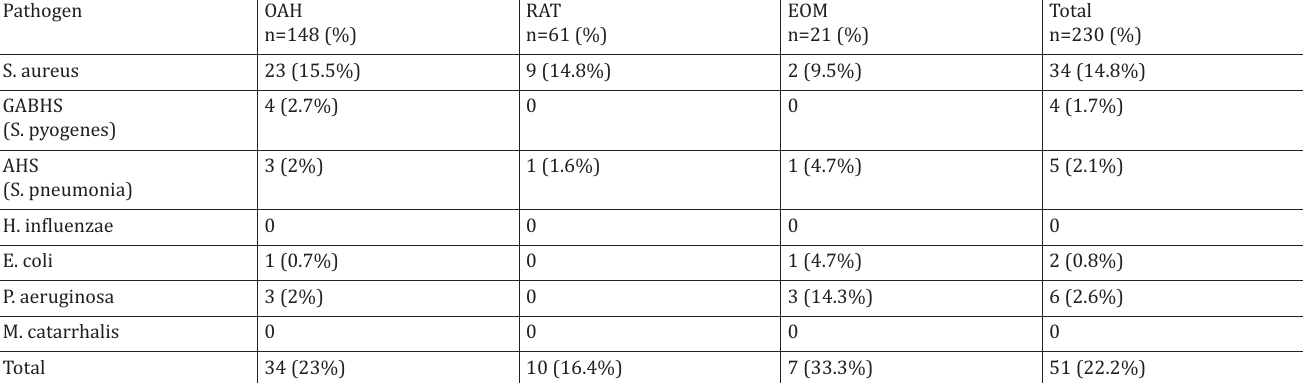
Pathogenic microorganisms cultured from the surface and /or core specimens of adenoids in all three groups.